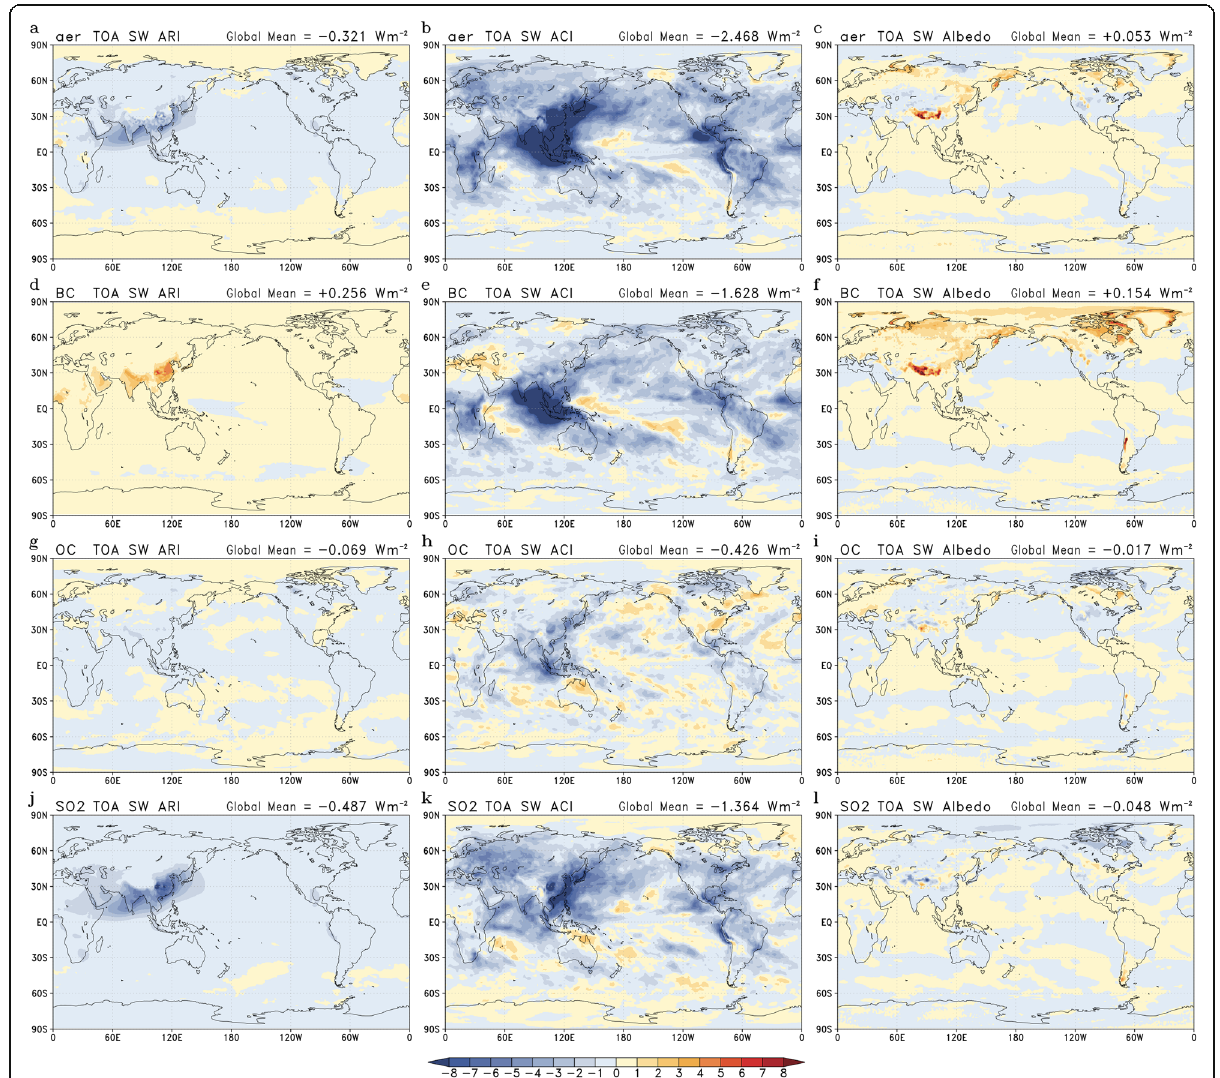
Fig. 4 Horizontal distributions of the annual mean shortwave (SW) ERFs (W m − 2 , filled contours) at the TOA separated into the aerosol-radiation interactions (ARI, left); aerosol-cloud interactions (ACI, middle); and surface albedo effects (Albedo, right) in the ( a – c ) piClim-aer (aer); ( d – f ) piClim- BC (BC); ( g – i ) piClim-OC (OC); and ( j – l ) piClim-SO2 (SO2) experiments in MRI-ESM2.0. The values of the global mean SW ERFs of each component are shown near the upper-right corner of each panel and are given in Table